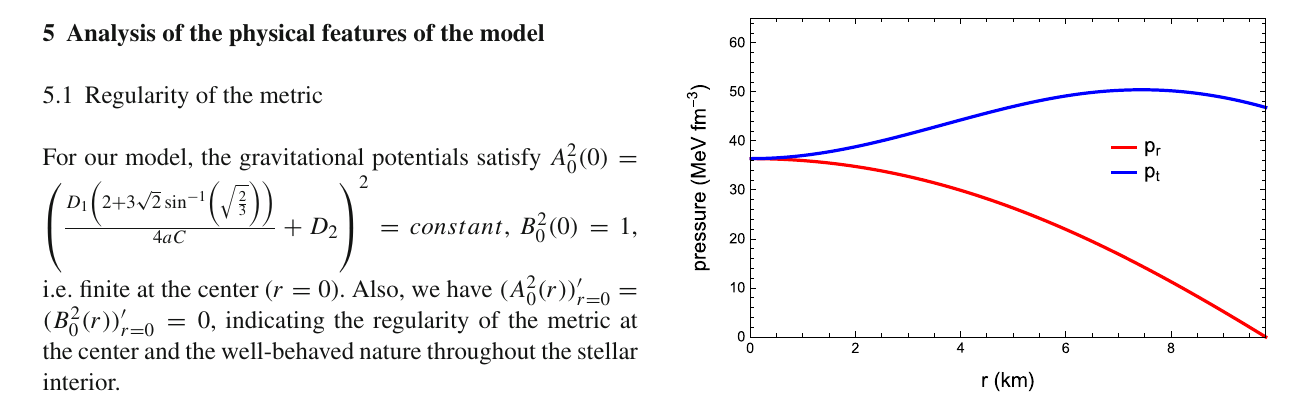
Fig. 3 Radial pressure and transverse pressure